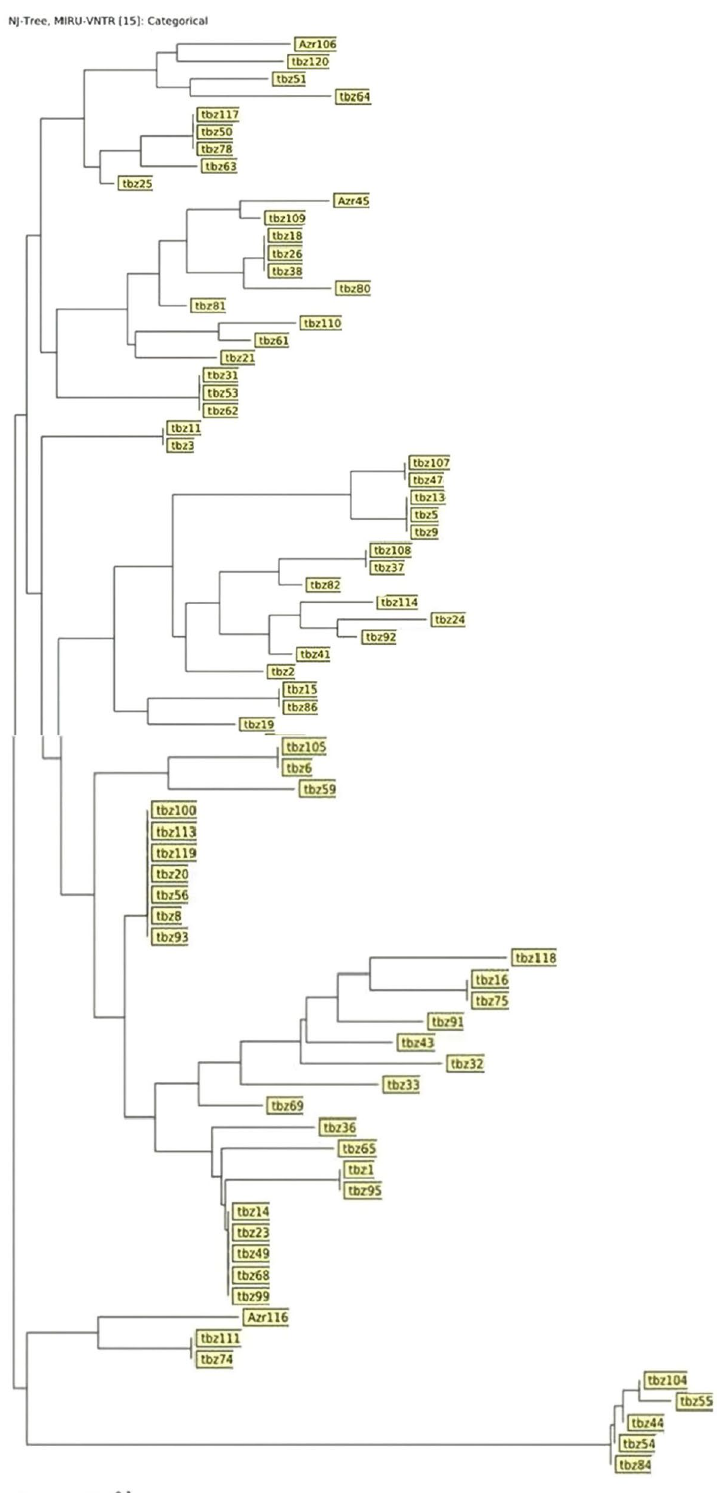
Fig. 1 Dendrogram of MIRU-VNTR pattern of 120 M. tuberculosis isolates obtained from new TB cases in Tabriz. This dendrogram shows clusters and samples with similar cluster based on MIRU-VNTR typing in 15 loci. The biggest cluster consists of 7 patients from Tabriz. Patients from Tabriz were identified by name started with tbz and patients from Azerbaijan were identified by names started with Azr. Number indicates random numbers assigned to each